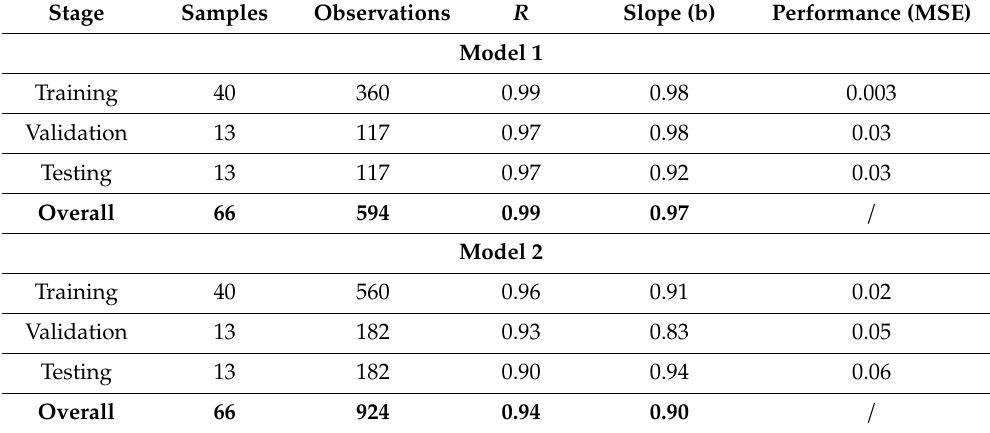
Table 3. Statistics from the artificial neural network models to predict the aroma profile based on the peak area of volatile aromatic compounds (Model 1) and the physicochemical data (Model 2) from Pinot noir